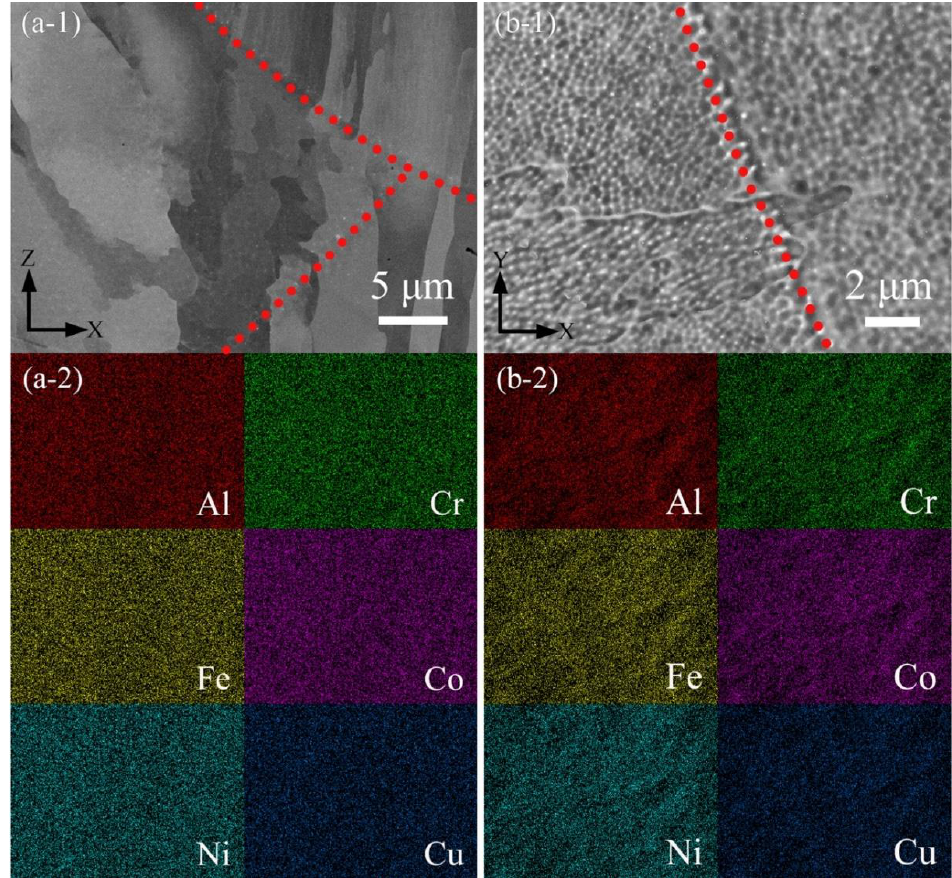
Figure 9. SEM observation on AlCoCr 0.75 Cu 0.5 FeNi specimen produced with the VED of 92.59 J/mm 3 ( P = 200 W, v = 1200 mm/s). ( a-1 ) BSE image on the mechanical polished xz-plane with ( a-2 ) corresponding quantitative EDS elemental mapping. ( b-1 ) SE image on the electrochemically etched xy-plane with ( b-2 ) corresponding quantitative EDS elemental distributions. Red dotted lines indicate the melt pool boundaries.